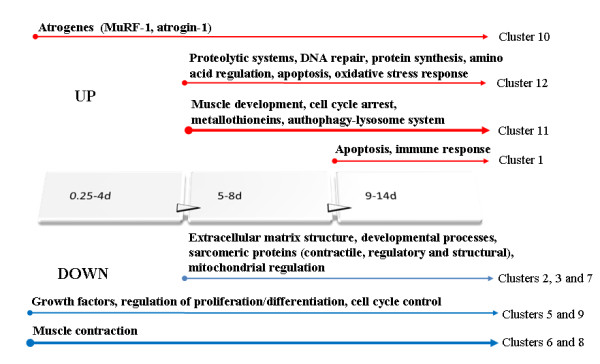
Graphical summary of significant temporal gene expression patterns according to K-means cluster analysis. Red and blue arrows show up- and down-regulation, respectively. Thin arrows indicate 2- to 4-fold change and thick arrows more than 4-fold change of gene expression.